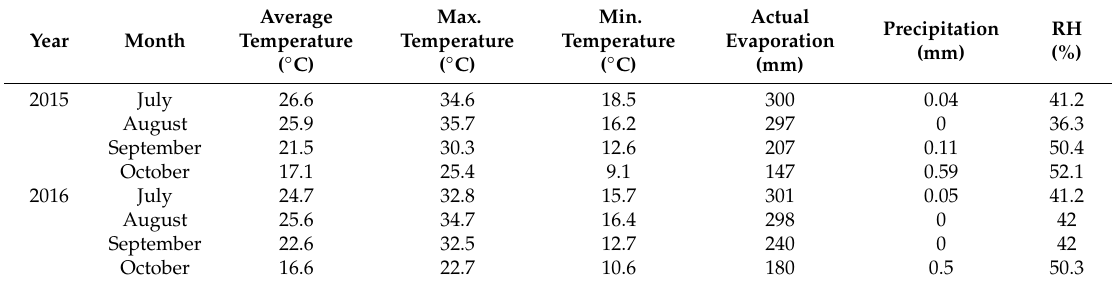
Table 1. Meteorological data of the experimental site during the growing season in 2015 and